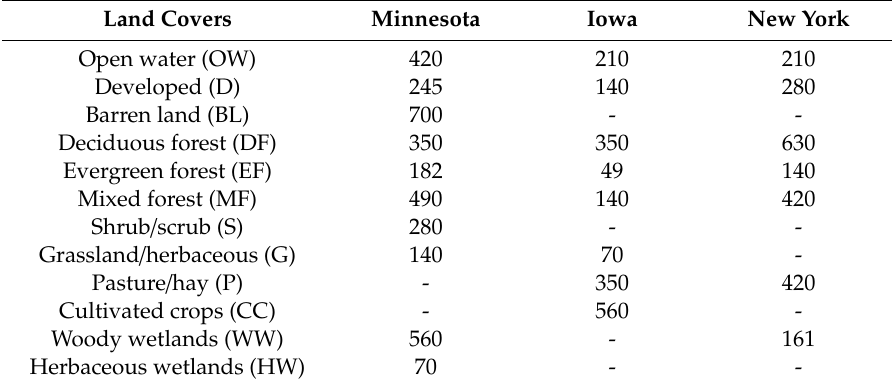
Table 2. The number of training pixels for each land cover type in the three study areas. Land Covers Minnesota Iowa New York Open water (OW) 420 210 210 Developed (D) 245 140 280 Barren land (BL) 700 - - Deciduous forest (DF) 350 350 630 Evergreen forest (EF) 182 Mixed forest (MF) - - Cultivated crops (CC) -